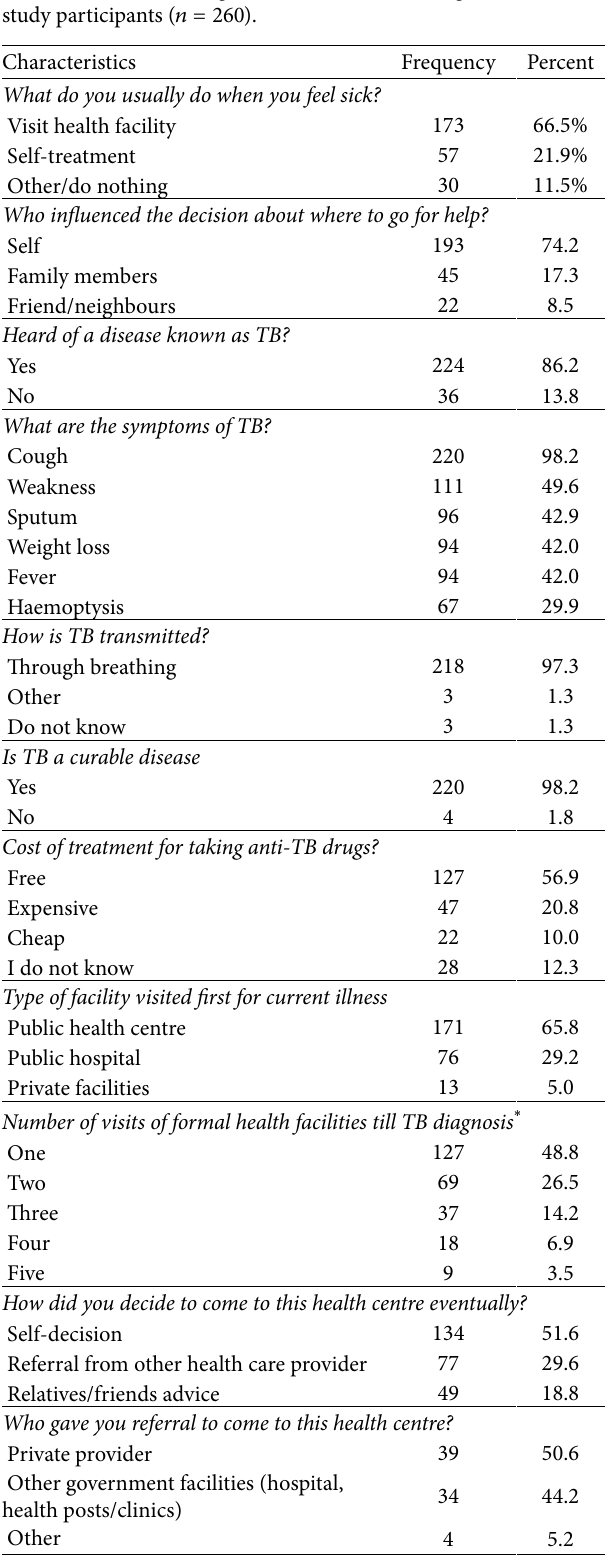
Table 2: Health seeking behaviour and knowledge on TB of the study participants ( 𝑛 = 260 ).